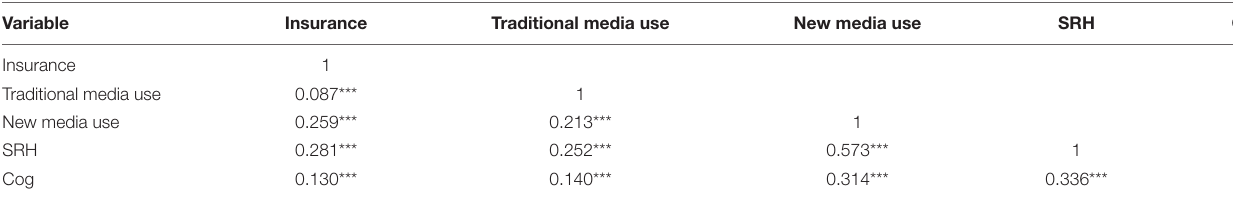
TABLE 3 | Correlations among study